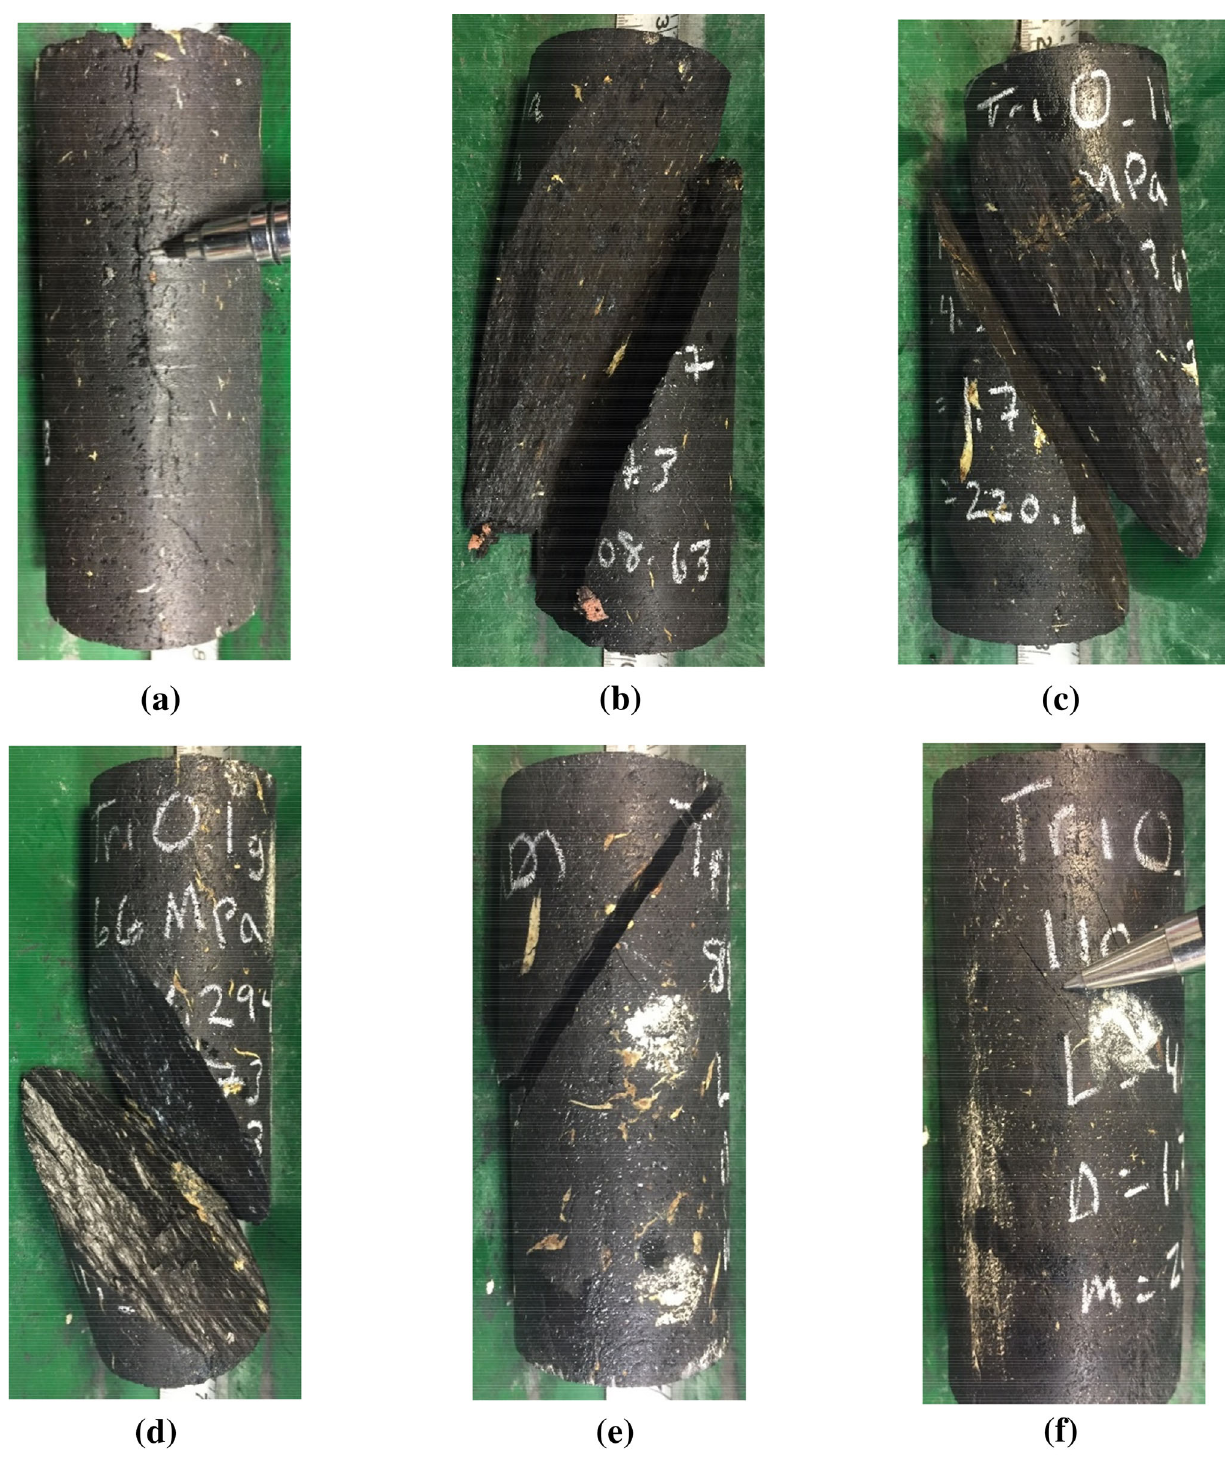
Fig. 2 Examples of failed coal specimens with 0 (cid:3) included angle (mean UCS 22 MPa) after triaxial compressive strength testing: a confining stress of 11 MPa; b confining stress of 22 MPa; c confining stress of 44 MPa; d confining stress of 66 MPa; e confining stress of 88 MPa; f confining stress of 110